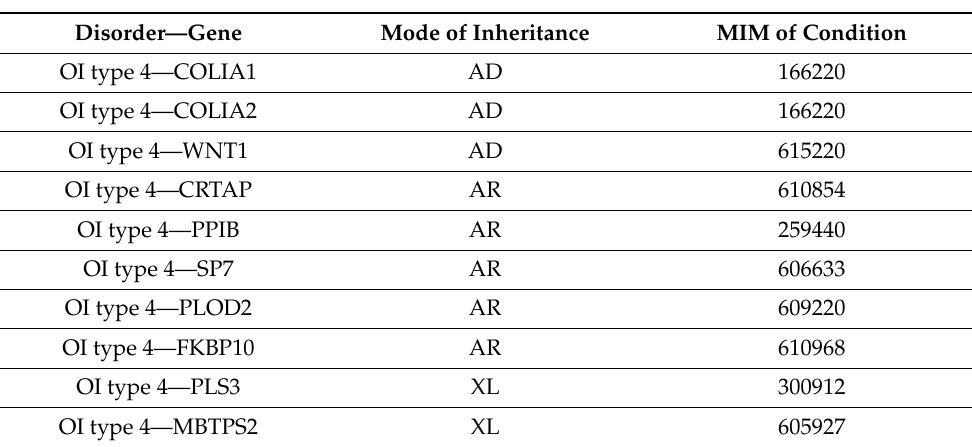
Table 6. Common variable OI with normal sclerae (OI Type